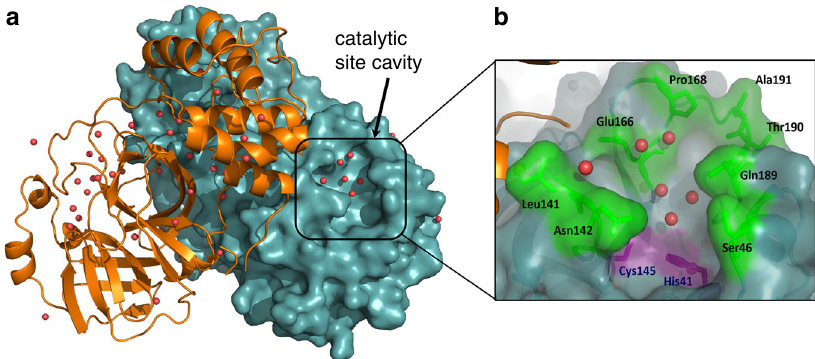
Fig. 1 The three-dimensional structure of 3CL M pro from SARS-CoV-2. a One monomer of the dimer is shown as an orange cartoon, while the other monomer is shown as a teal surface with the catalytic site cavity highlighted with water molecules shown as red spheres. b A closeup view of the catalytic site cavity in which the catalytic residues (Cys145 and His41) are highlighted in purple with the residues that fl ank the cavity highlighted in green with water molecules shown as red